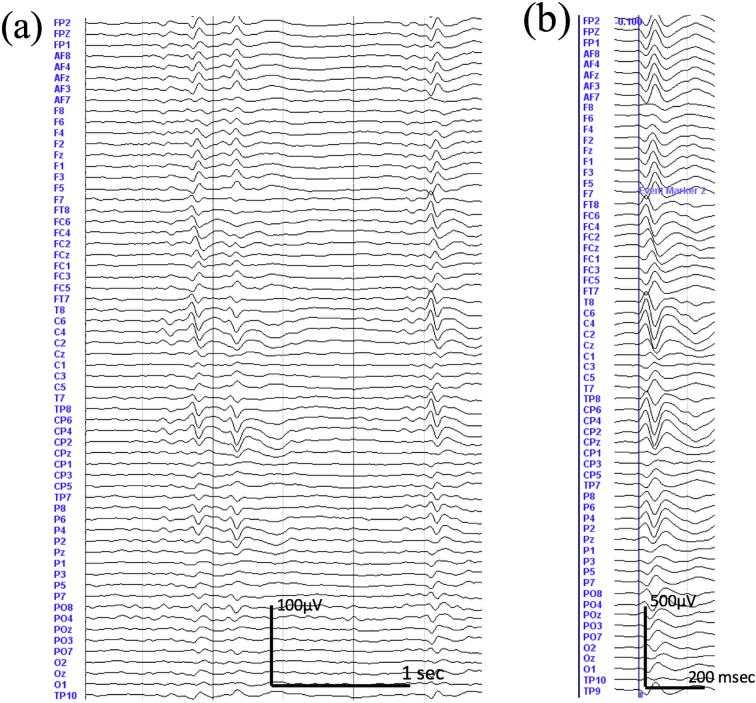
Patient EEG. (A) Raw data of one of the patients filtered between 0.5 and 15 Hz with interictal epileptic spikes (IES) in the right hemisphere electrodes (C4, C6, T8, CP4, CP6 and TP8). (B) The grand average of 50 IES showed high amplitude spike activity in the right hemisphere electrodes.